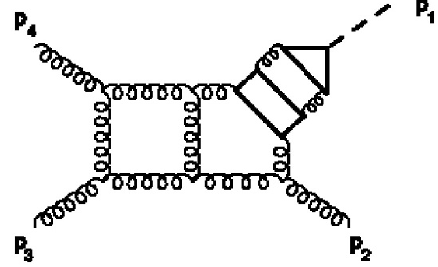
Figure 22. Planar (cid:12)ve-loop diagram contributing to H + j